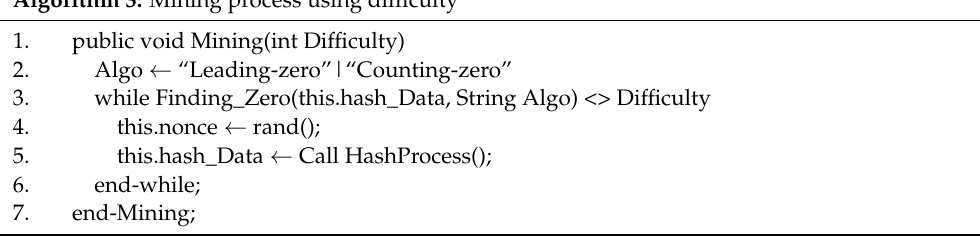
Algorithm 3: Mining process using